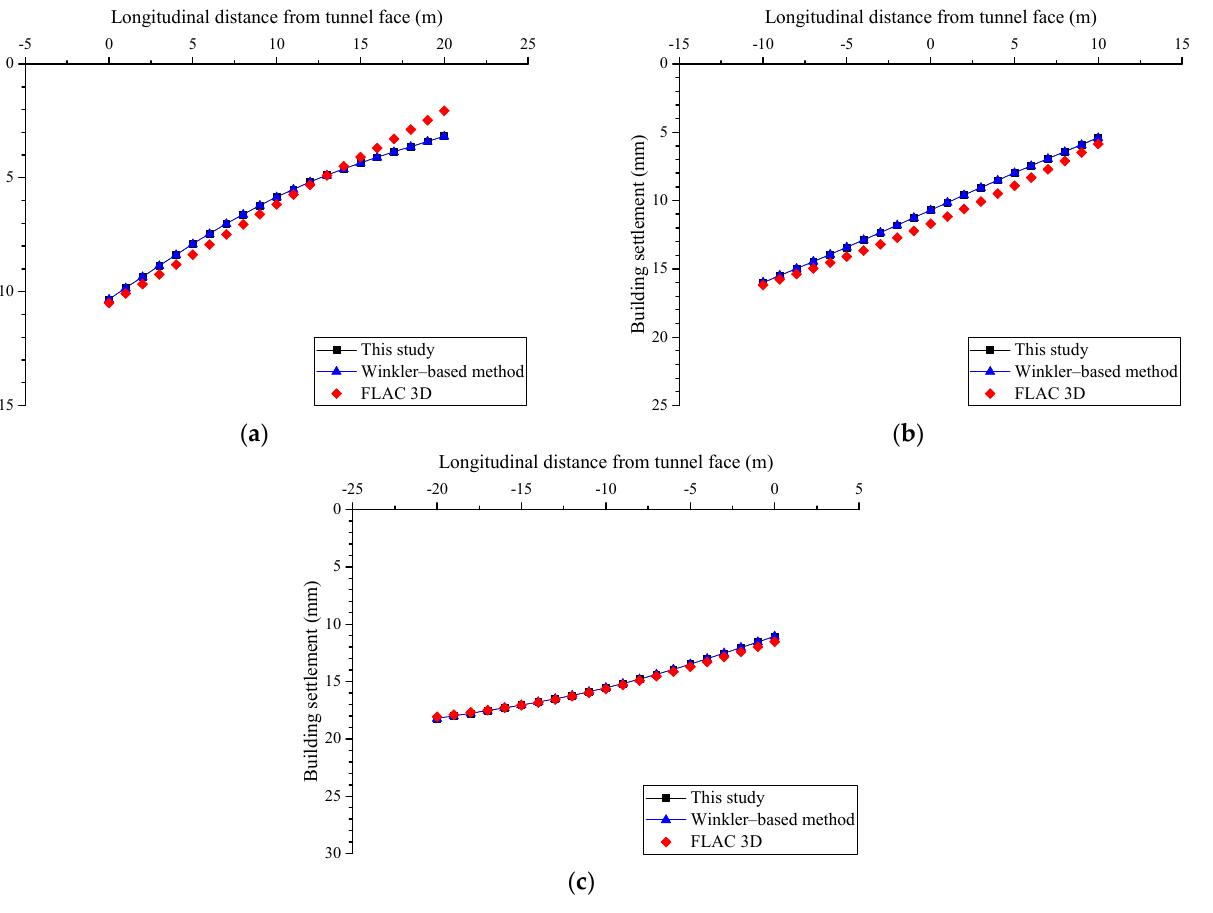
Figure 8. Comparison with building settlement from finite difference method: ( a ) s 1 = 0; ( b ) s 1 = − 10.0 m; ( c ) s 1 = − 20.0 m.